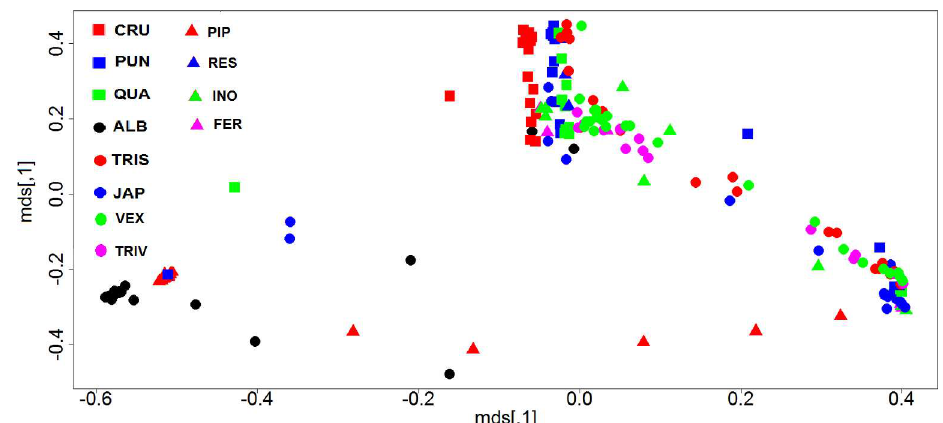
Fig 4. Principal coordinates analysis (PCoA) comparing the bacterial communities across 12 mosquito species. PCoA was based on Bray-Curtis distance values computed for mosquito communities at the 97% OTU level. CRU = An . crucians , PUN = An . punctipennis , QUA = An . quadrimaculatus , ALB = Ae . albopictus , JAP = Ae . japonicus , TRIS = Ae . triseriatus , VEX = Ae . vexans , TRIV = Ae . trivittatus , PIP = Cx . pipiens , RES = Cx . restuans , INO = Cs . inornata , FER = Ps . ferox